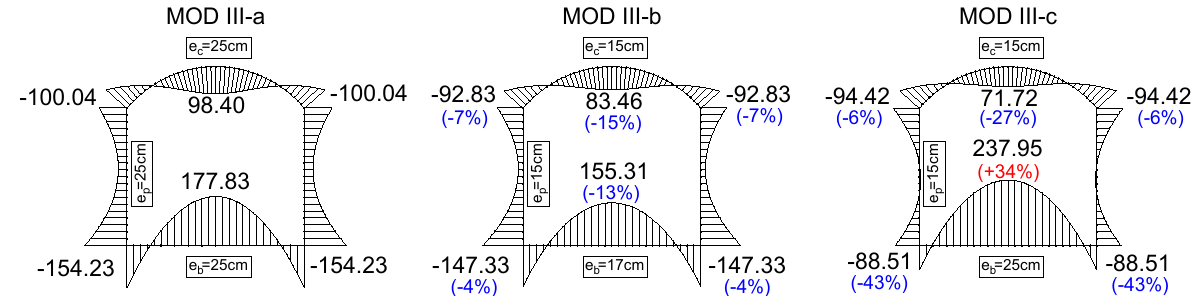
Figure 12. Bending moments (kN·m) for different wall thicknesses in the modified culvert (H = 10m).